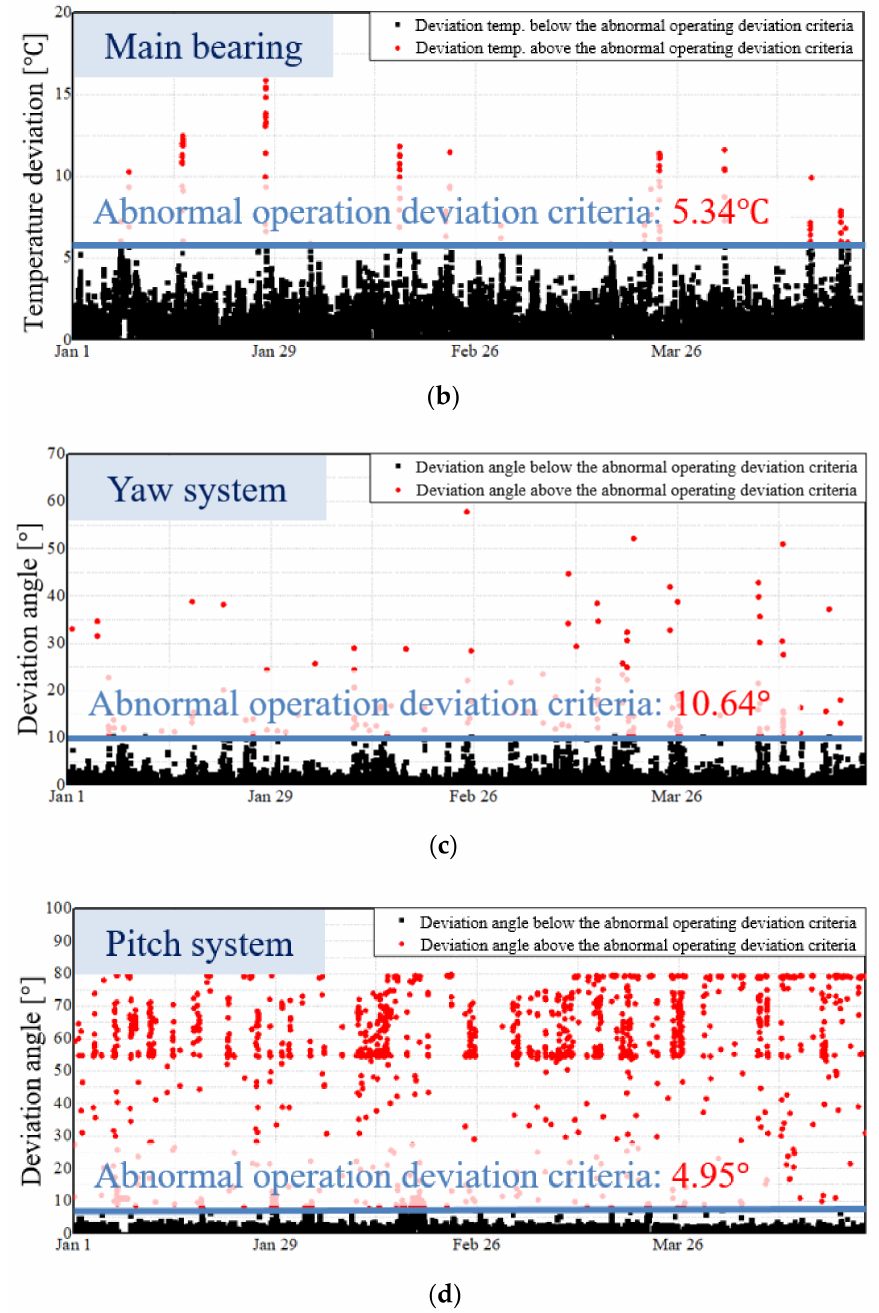
Figure 9. Results of the condition monitoring, ( a ) generator; ( b ) main bearing; ( c ) yaw system; ( d ) pitch system.